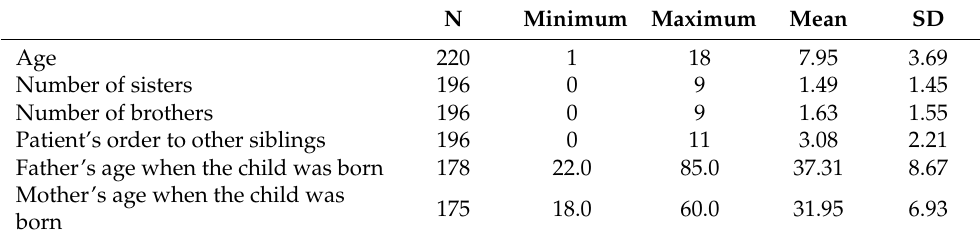
Table 2. Age of affected children and age of parents.